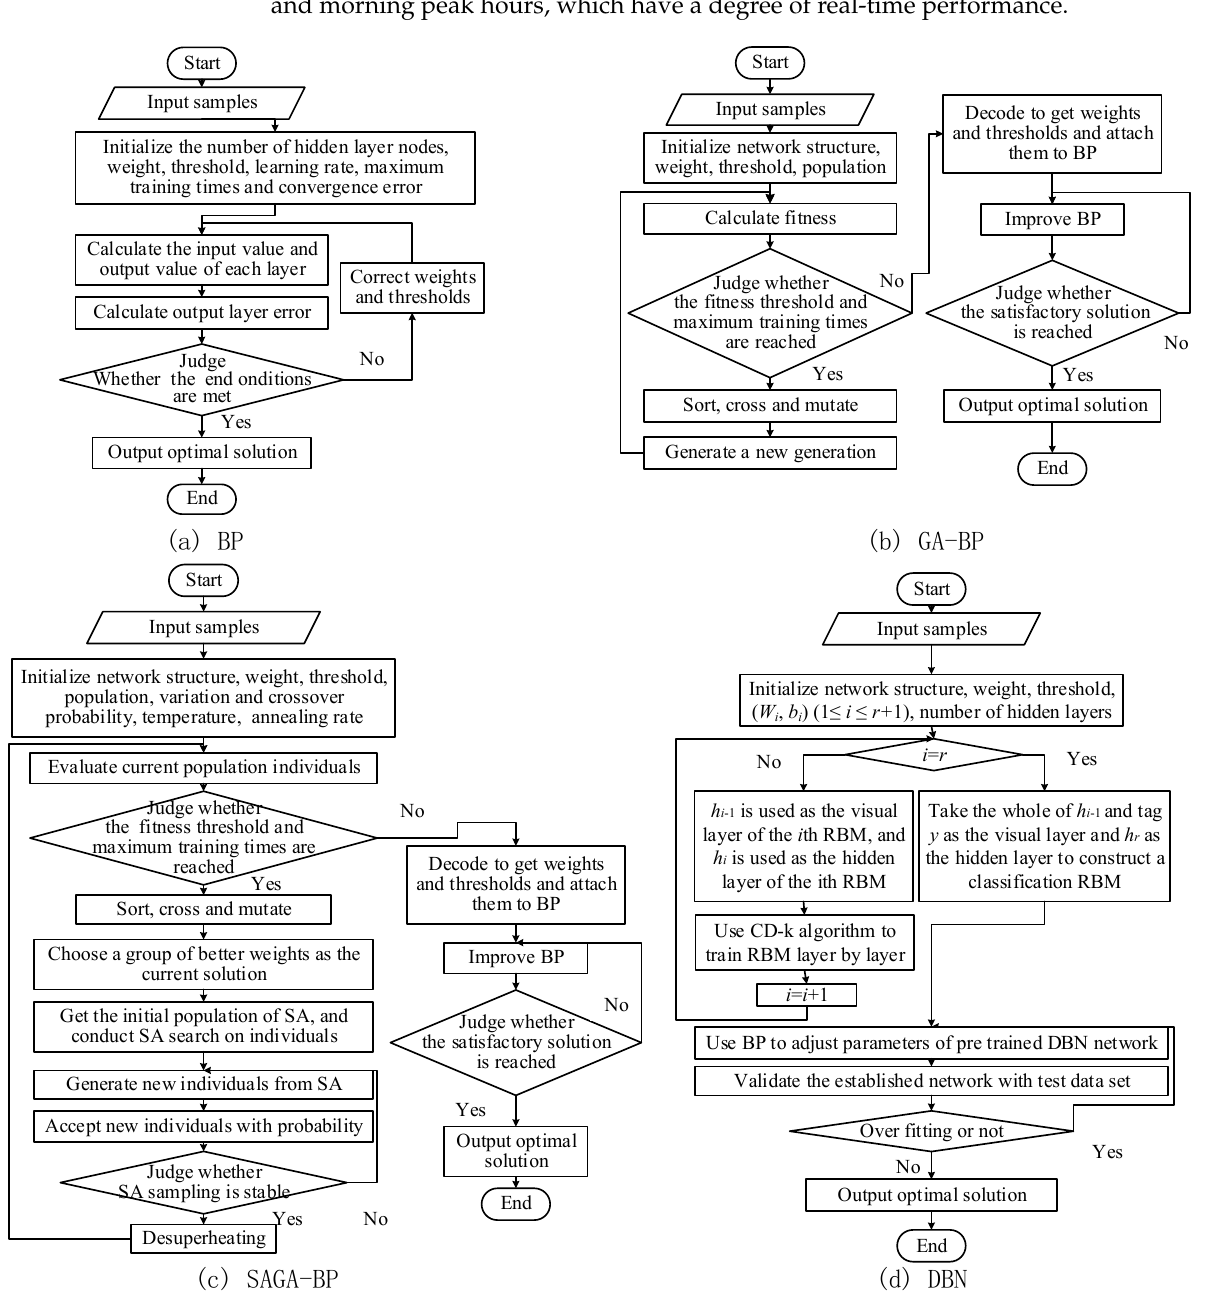
Figure 7. The flow chart of each algorithm. Table 3. Parameters of algorithms.